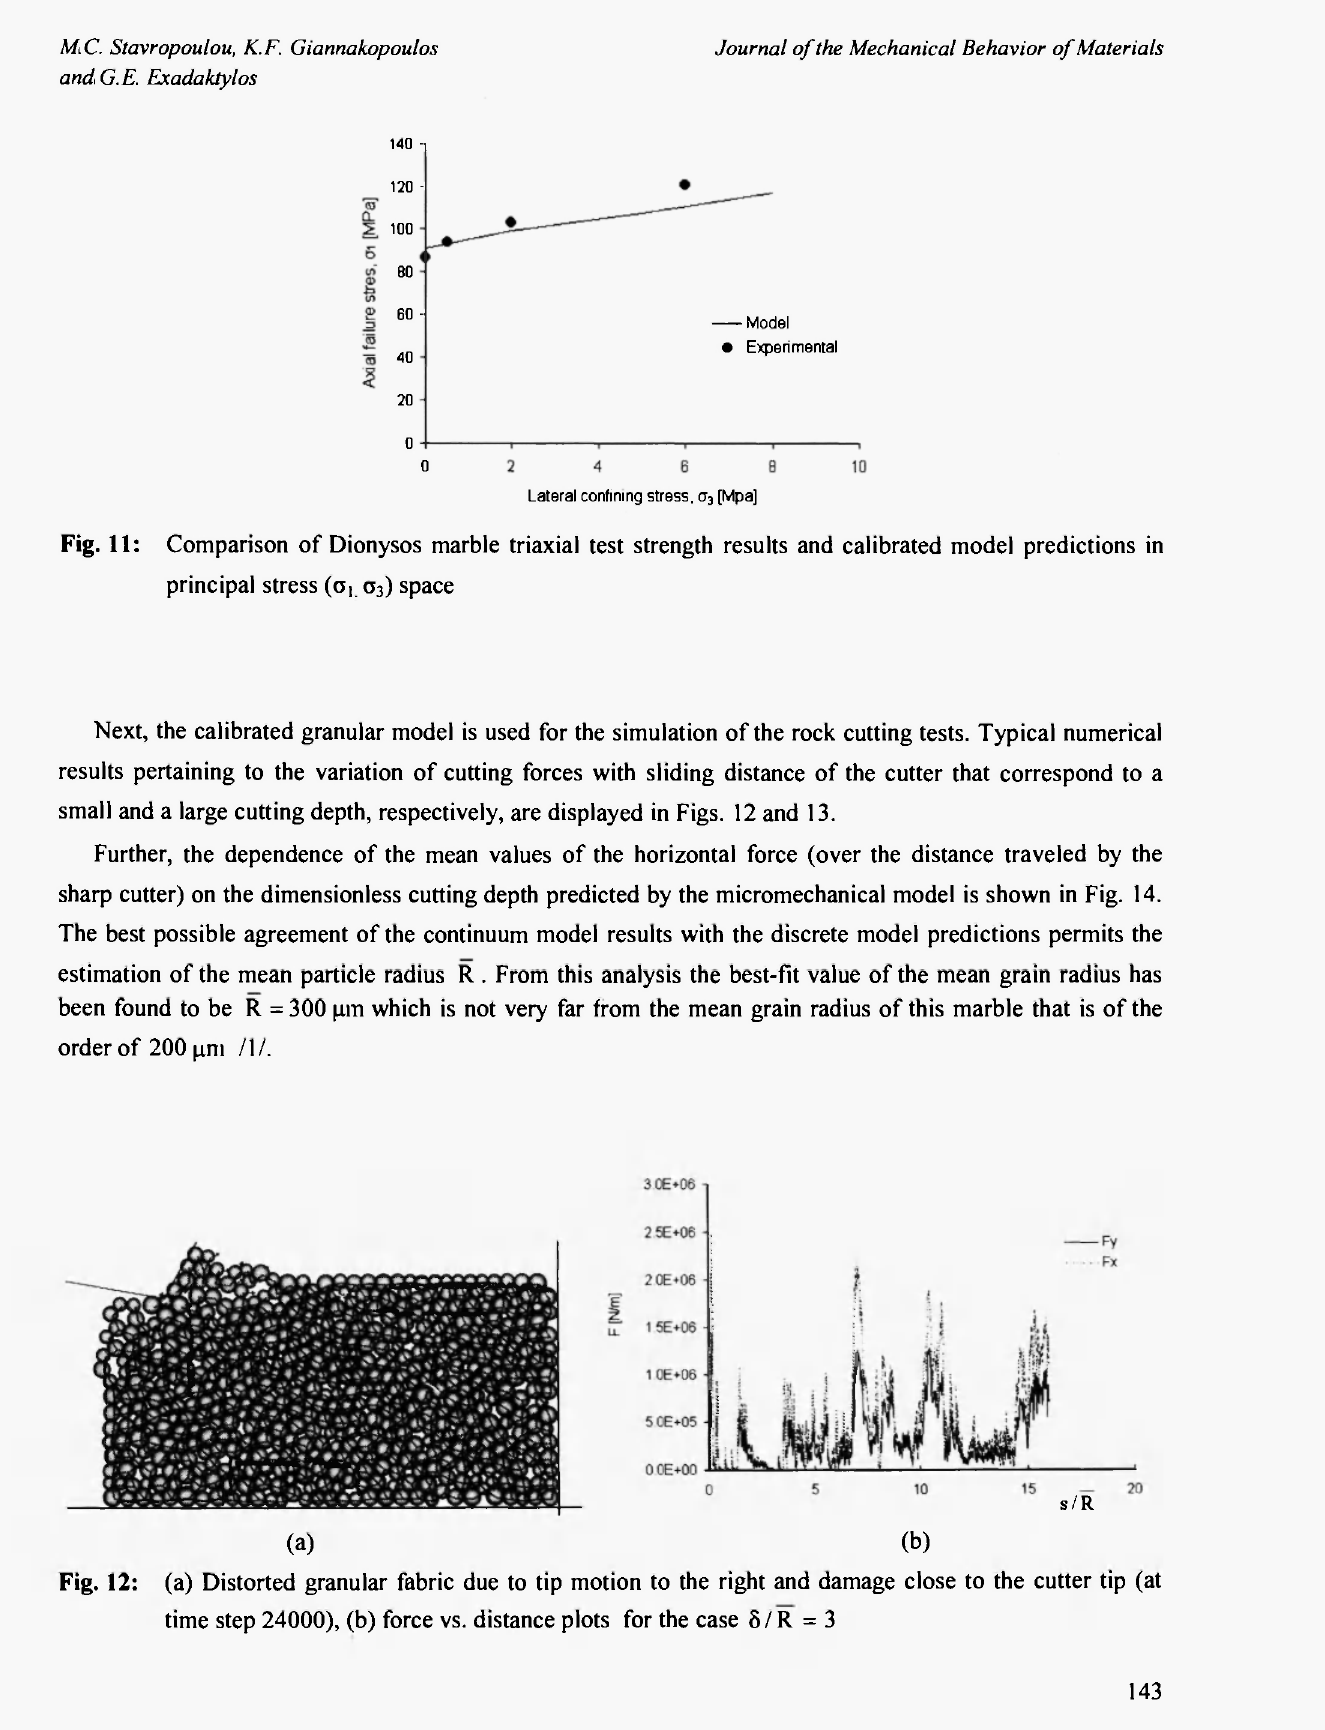
Fig. 12: (a) Distorted granular fabric due to tip motion to the right and damage close to the cutter tip (at time step 24000), (b) force vs. distance plots for the case δ / R =